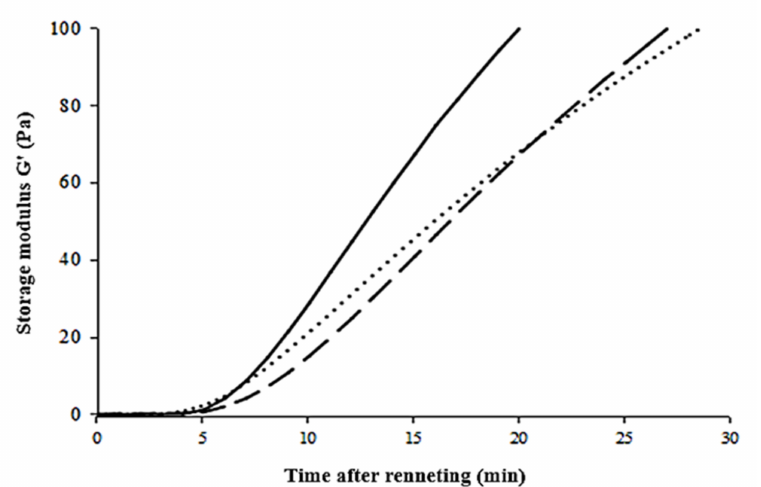
Figure 1. Curves of rennet-coagulation kinetics followed by rheology for cheese milk made from control skimmed milk or 0% (full line), 50% (dashed line) and 100% (dotted line) of pasteurized white-wastewater concentrates (CWW): evolution of storage modulus (G’) as a function of